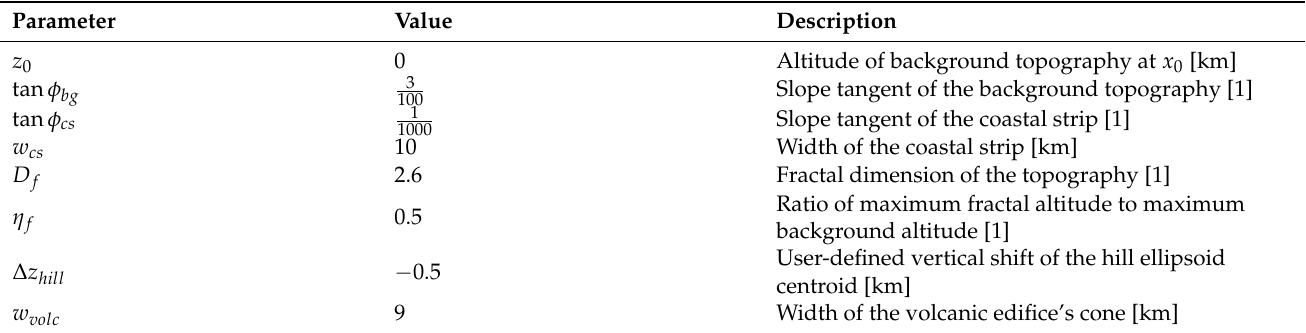
Table A3. Default parameterization for the topography and soil